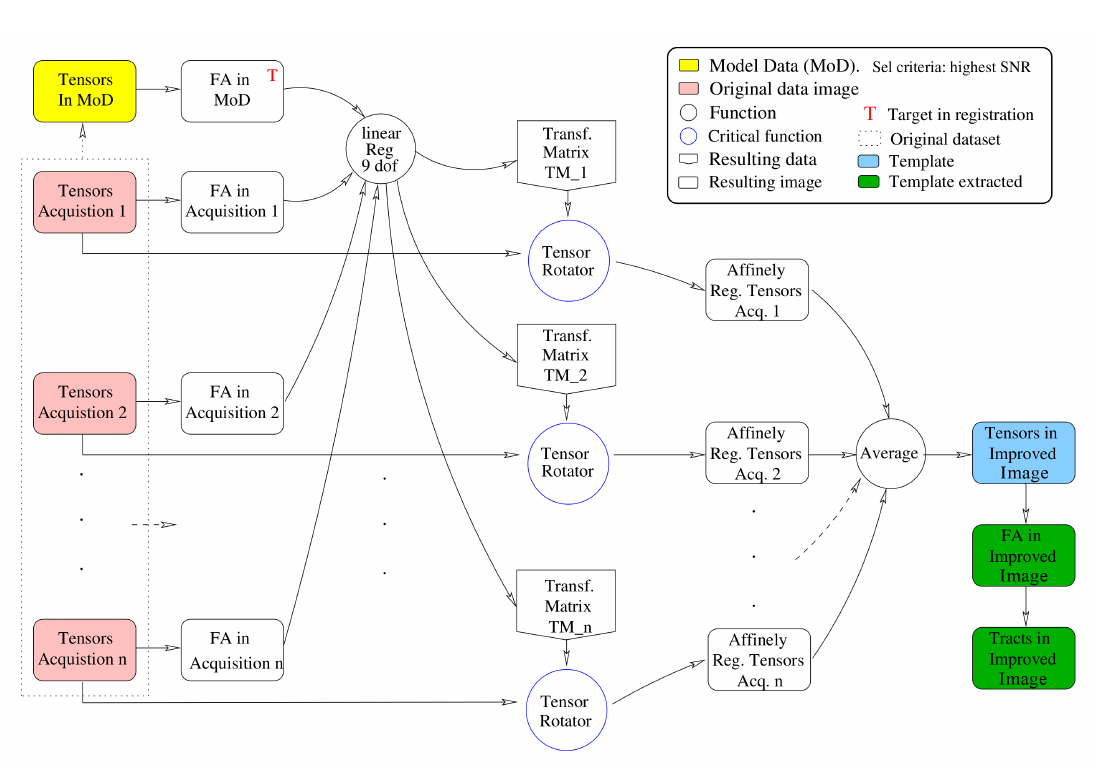
Figure 2: Pipeline to improve image quality. First, we obtain the tensor information for each acquisition to generate the FA maps. Linear registration in the FA domain produces transformation matrices. The resulting transformation matrices are used to rotate the tensors and align them to the underlying anatomy [36]. Finally, we average all acquisitions to obtain images with enhanced quality. Note that all the images belong to the same subject; therefore, non-linear registration is not